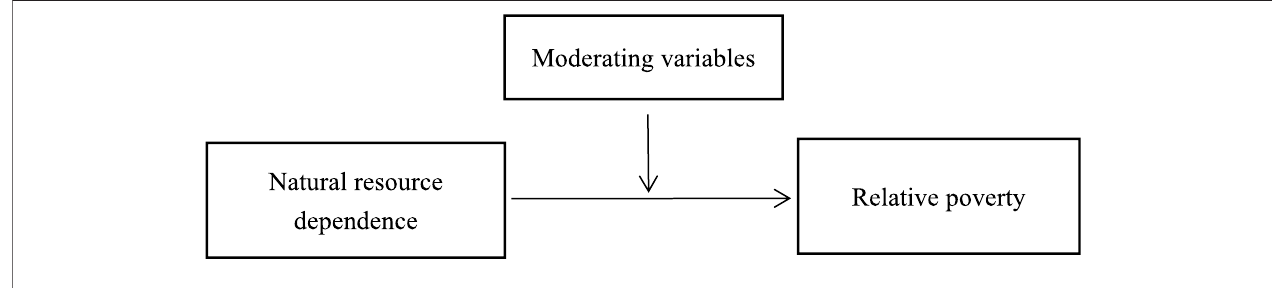
FIGURE 1 | Path analysis diagram of moderating